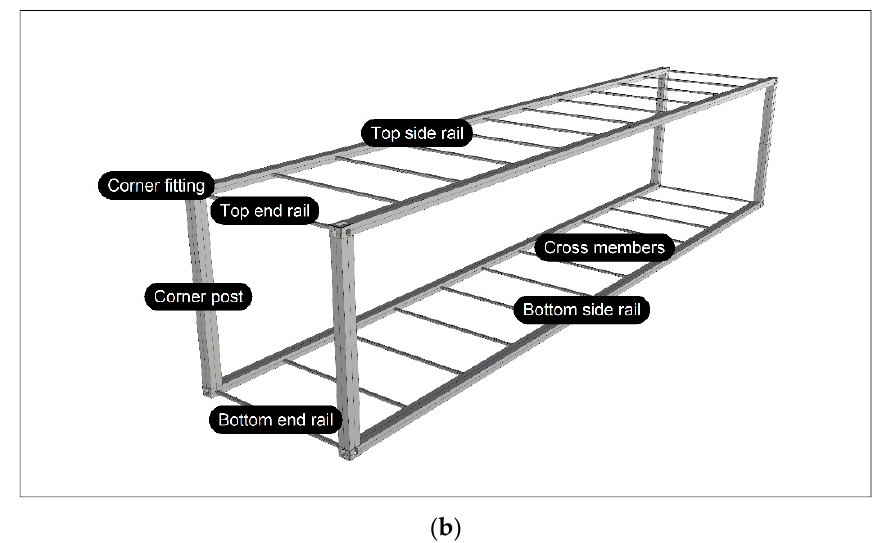
Figure 1. ( a ) The exterior view of a standard 40-foot ISO container made of steel, and ( b ) the interior view of the structural components of a container.